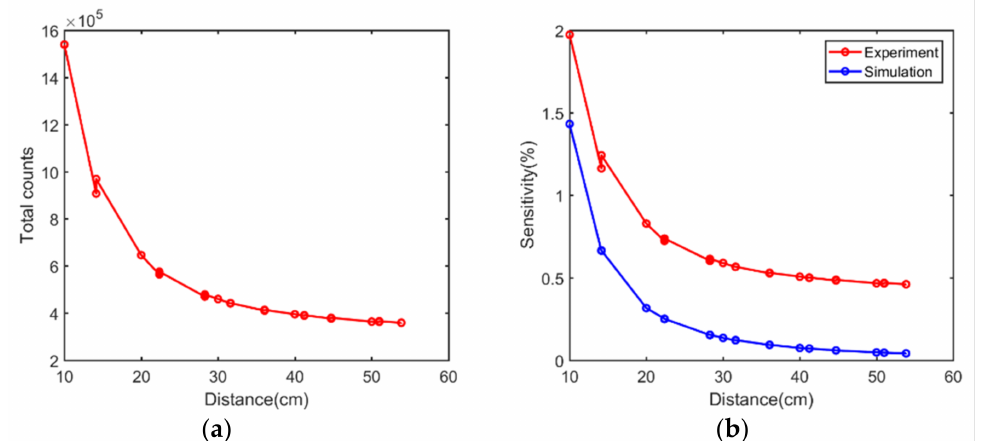
Figure 13. Experimental results of ( a ) events number plot versus distance, and ( b ) sensitivity plot versus